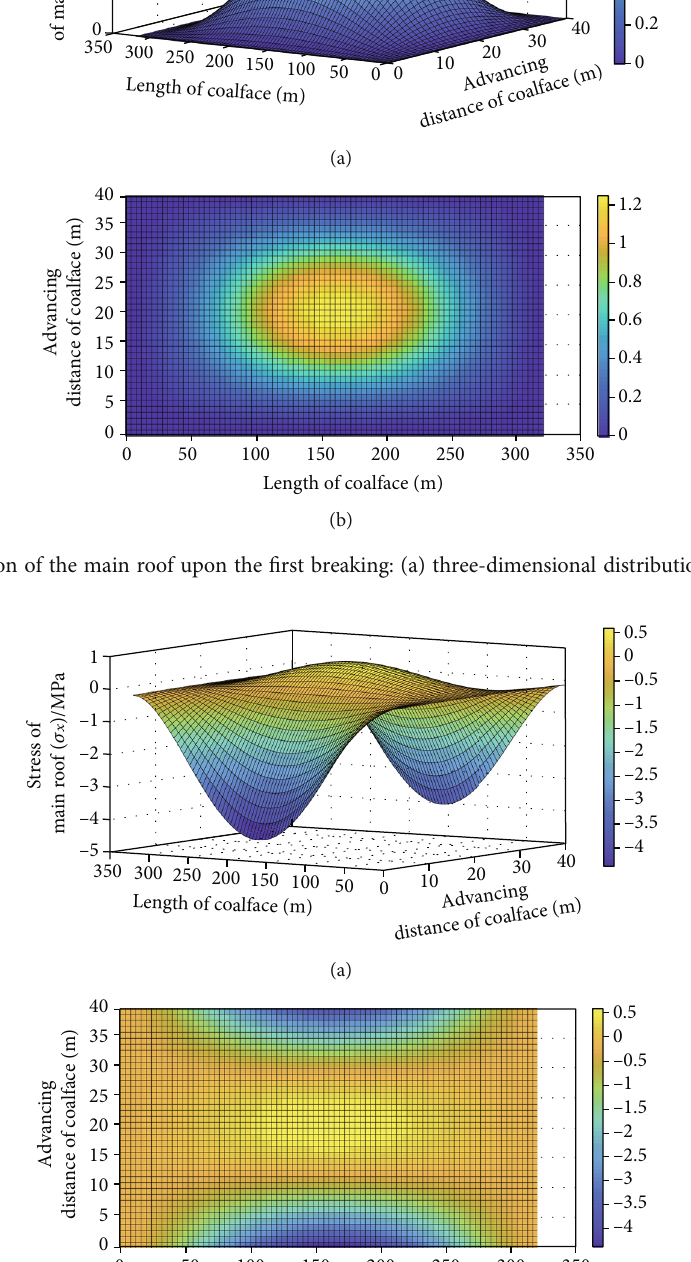
Figure 4: Distribution characteristics of the stress σ stress σ x and (b) planar distribution of the stress σ x